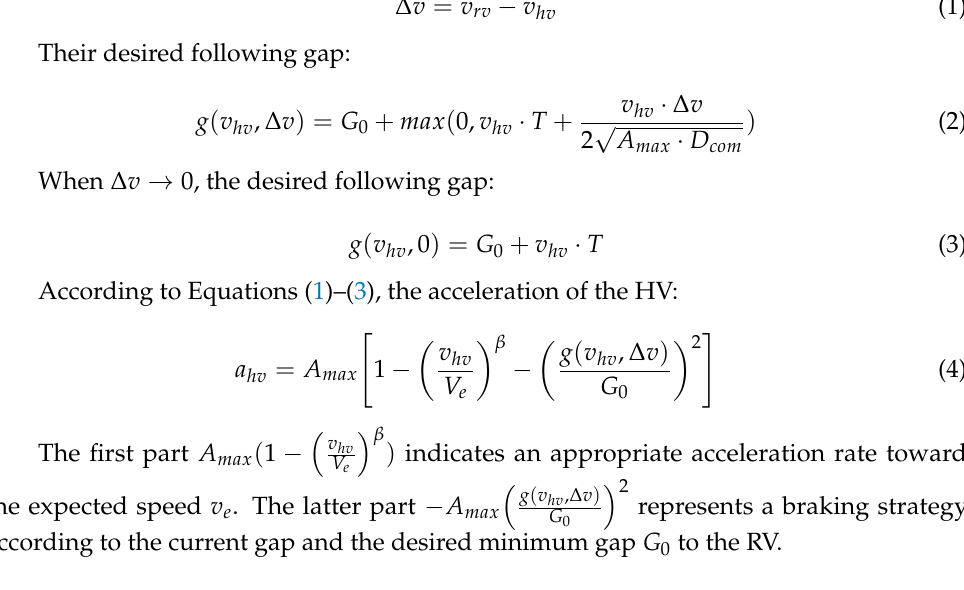
Table 3. IDM model parameter notation. Parameters